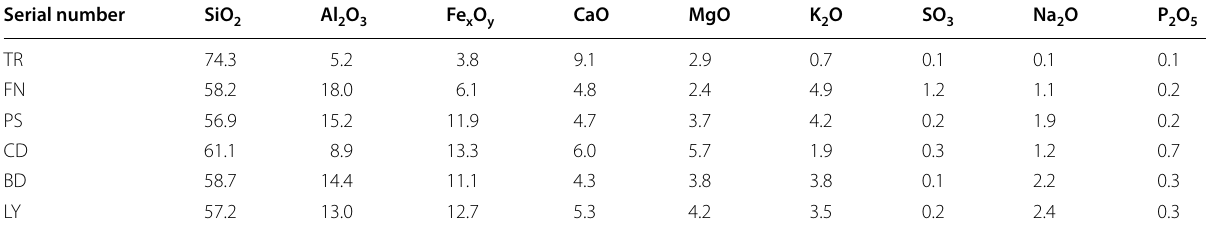
Table 1 Chemical compositions of fine aggregates (%)